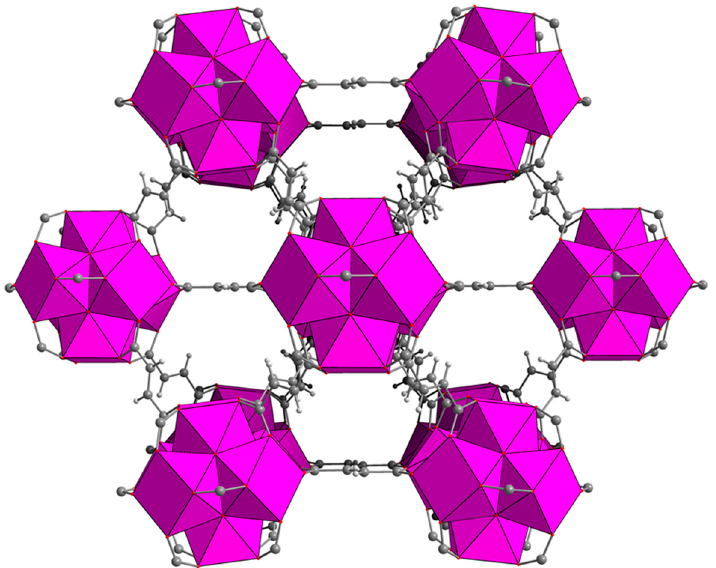
Figure 1. Crystal structure of MOF-801. Colour code: Zr, pink; C, grey; O, red; H, white.